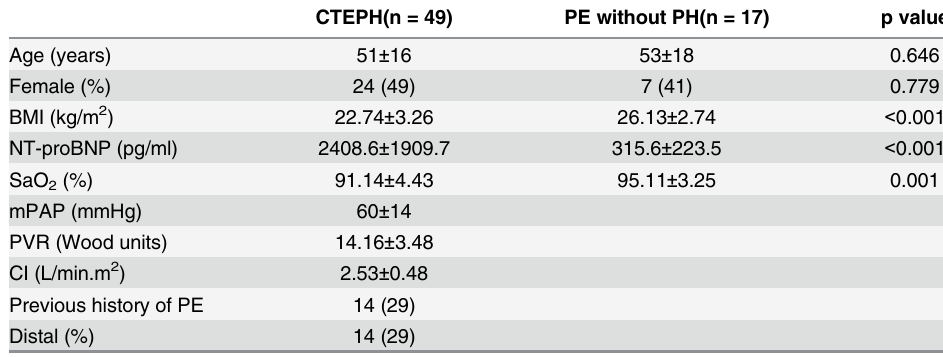
Table 2. Clinical characteristics of study